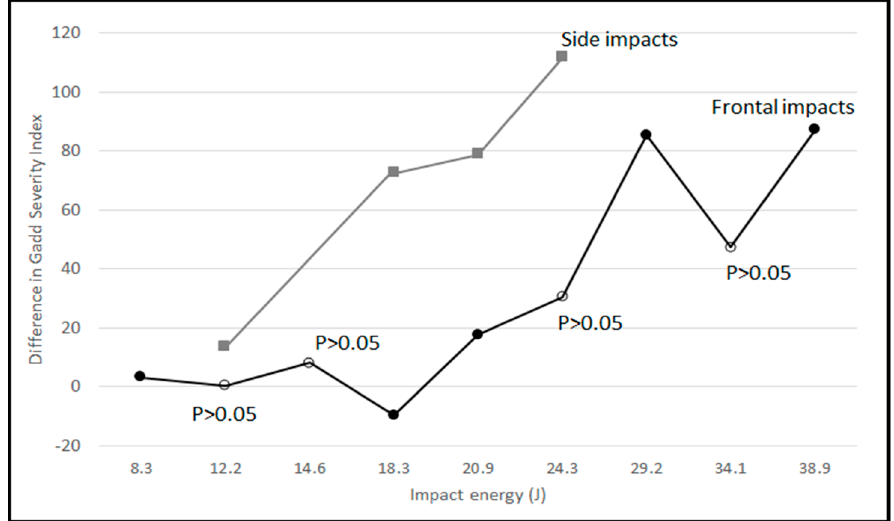
Figure 6. The difference in Gadd Severity Index between conventional foam inserts and auxetic foam inserts for the front and side impacts, labeled where these differences were not significant based on t -test p > 0.05 (open markers).